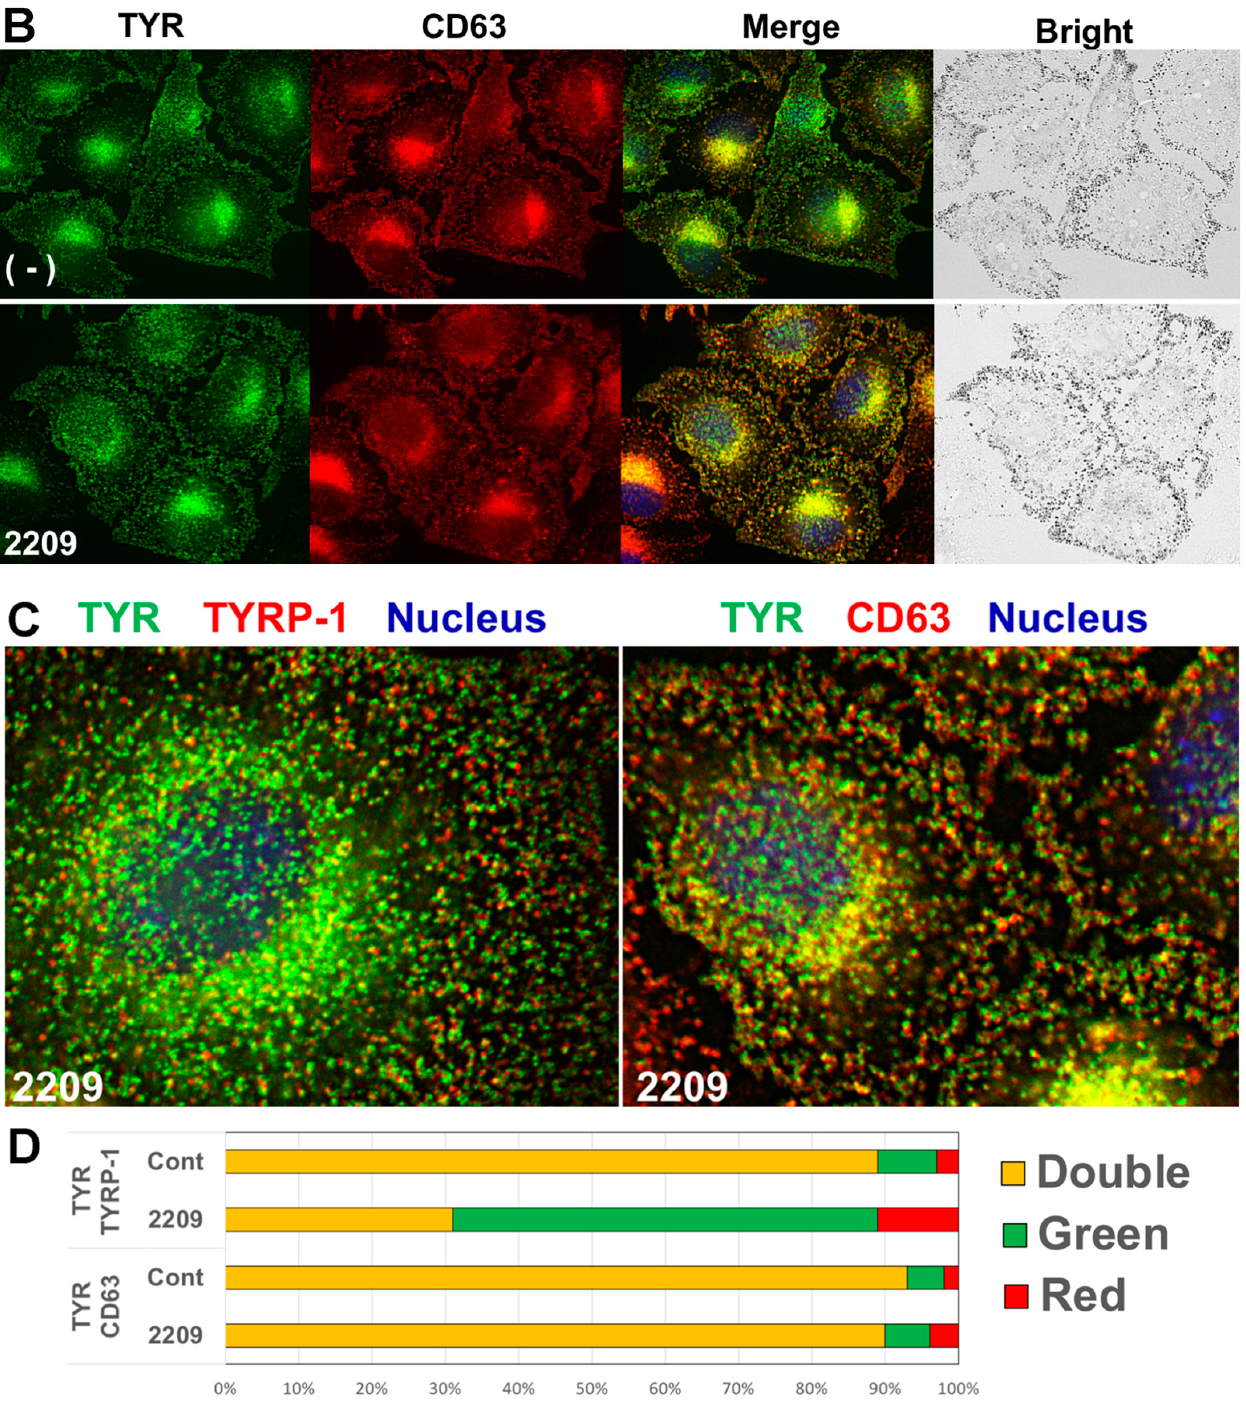
Figure 4 . B16F10 cells whose melanogenesis had been initiated by 20 μ M of Fsk for 24 h were further treated with or without GIF-2209 (10 μ M) for 24 h. Then, the cells were stained with anti-TYR (green) and anti-TYRP-1 (red) antibodies ( A ) or an-ti-CD63 (red) antibodies ( B ). Digital magnification images are shown in ( C ). ( D ) Twenty cells from each staining were selected, and 100 vesicles in each cell were classified into three categories: double positive (orange) or single positive (green or red). Statistical significance ( p < 0.05, Student’s t -test) between control and GIF-2209-treated cells was observed for double-positive (TYR and TYRP-1) spots and TYR single positive spots in cells.